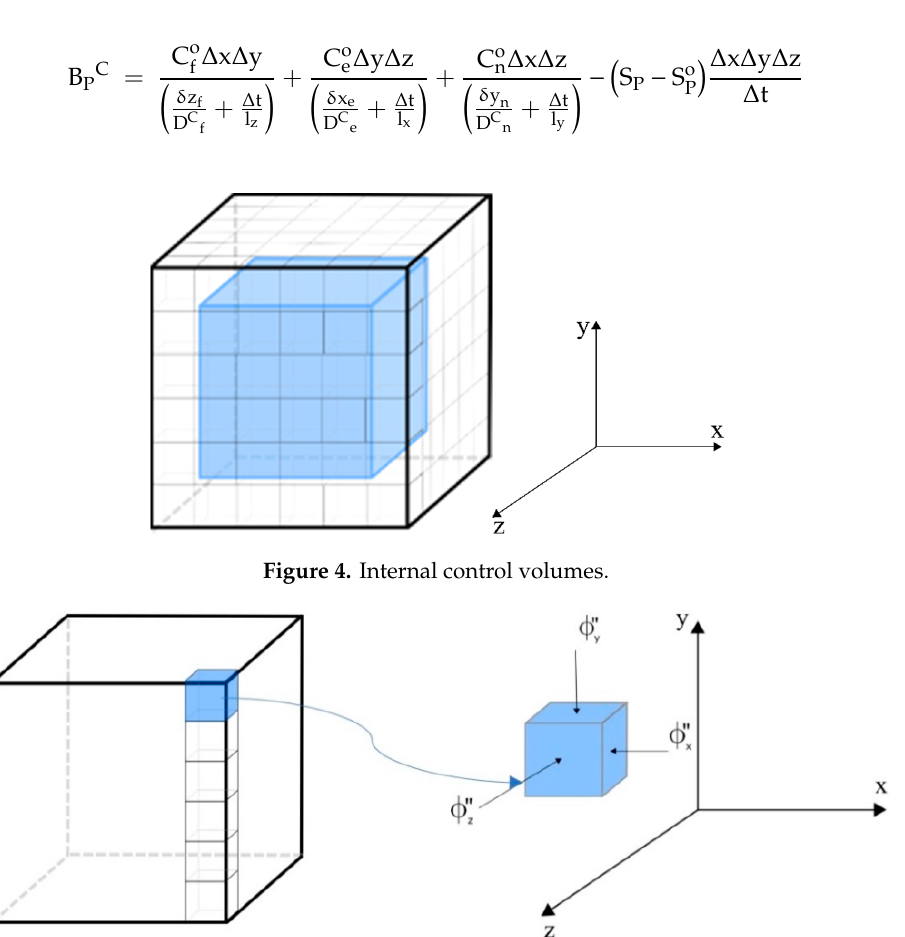
Figure 5. Volume with mass flow conditions in the x, y, and z